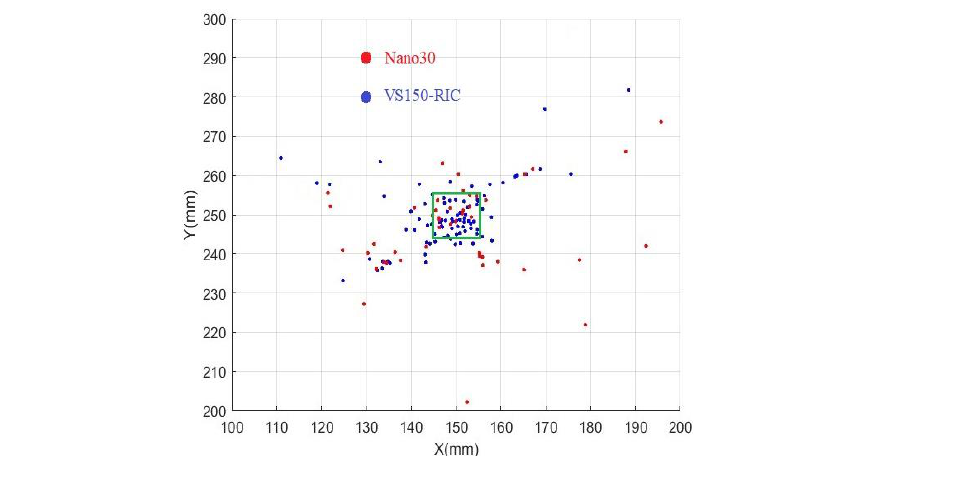
Figure 13. Results of source location of HIC events. Red dots: Nano30, blue dots: VS150-RIC. The green box is the charging area.